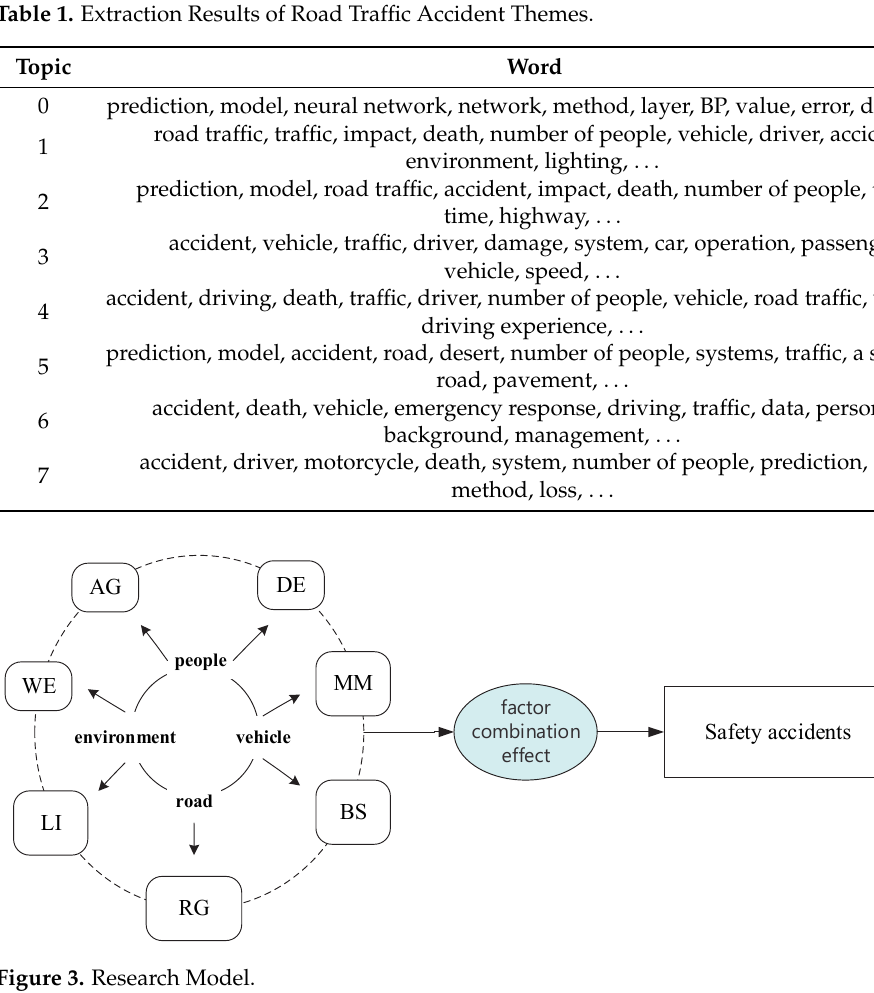
Figure 3. Research